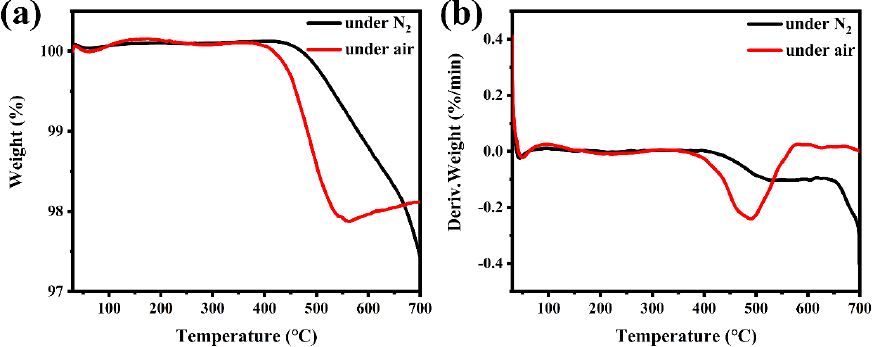
8 of 23 Figure 4. TEM images of C-MOF ( a , b ), SAED pattern of C-MOF ( c ), HRTEM image of C-MOF ( d ). The above characterization revealed that with the decomposition of organic ligands, MOF were converted to major Co 3 O 4 and minor CuO during the calcination at 500 °C for